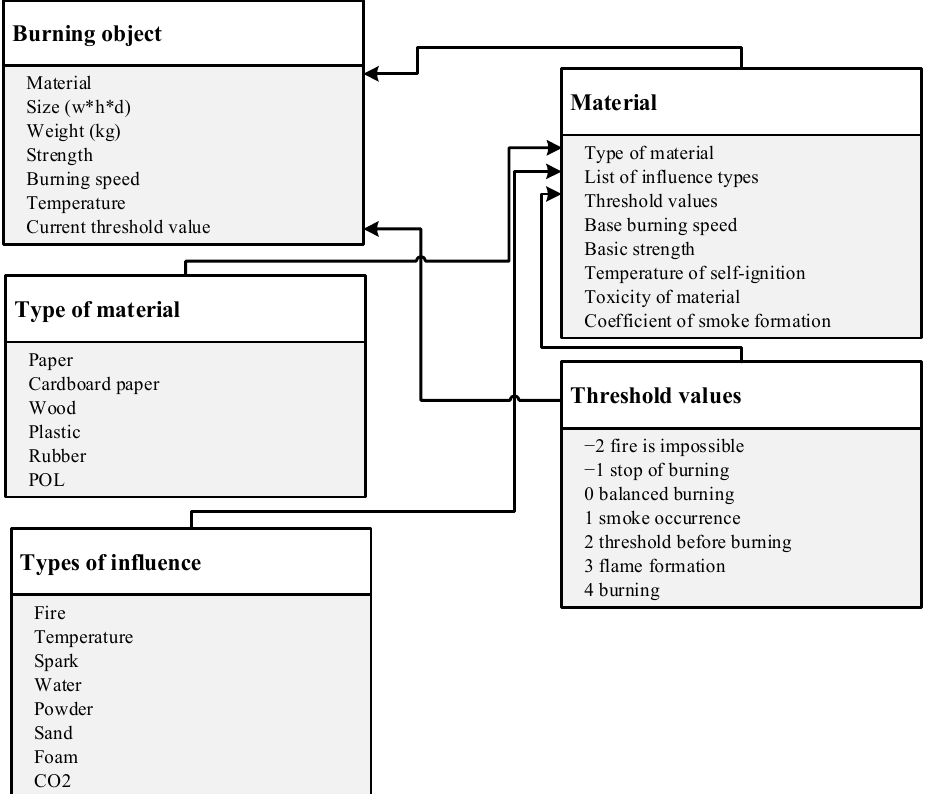
Figure 2. Structural diagram of the burning object. Source: developed by the